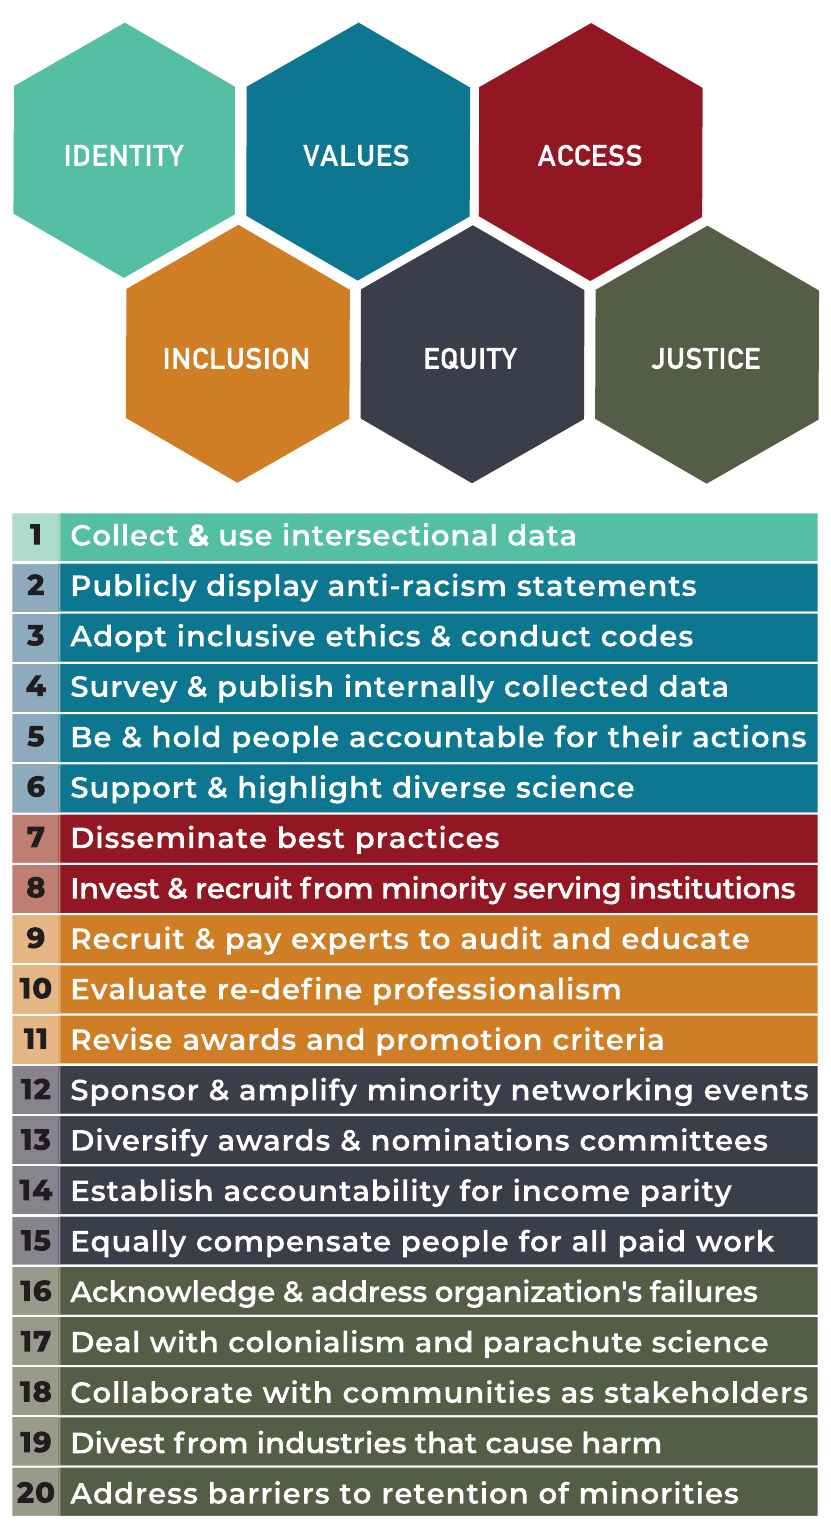
Fig. 2 Twenty action steps to build a robust anti-racist organization. Each action step is associated to an essential